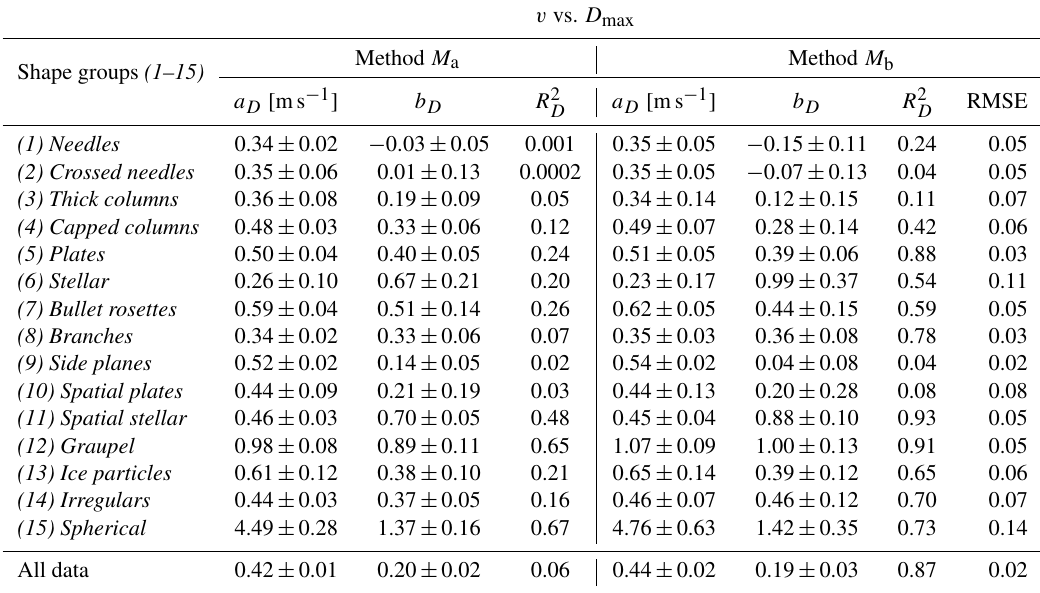
Table 3. Fall speed vs. particle size ( v vs. D max ) relationships fitted to Eq. (4) for each shape group and all data, i.e., for all the particles regardless of shape. The parameters a D , b D with their respective uncertainties and the correlation coefficients R 2 methods ( M a and M b ) for each shape group and regardless of shape. The RMSE values of base-10 logarithms of measured v vs. predicted v are also shown to indicate the uncertainty of these power laws.